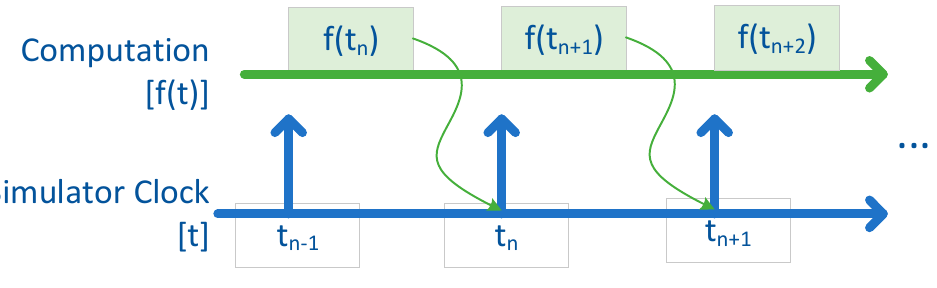
Figure 7. Real-time simulation, adapted from [56].